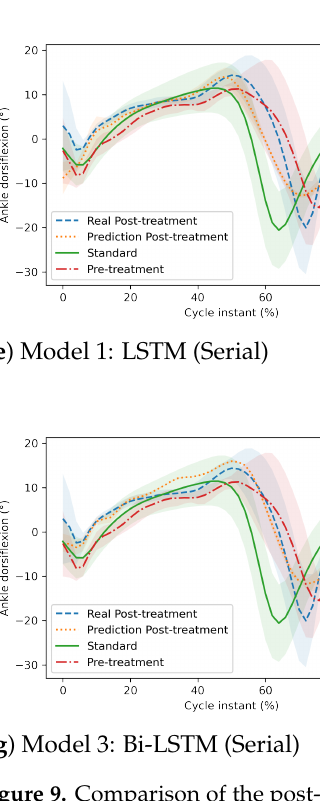
Figure 10. Cont. Figure 9. Comparison of the post-treatment gait trajectory of the knee and ankle joint in a patient diagnosed with MS. The first two models ( a , b ) are serial (Model 1 and Model 2), and the third and fourth models ( c , d ) are MTL models (Model 4 and Model 6), which represents the prediction of the knee joint. The fifth, sixth and seventh models ( e – g ) are serial (Model 1, Model 2, and Model 3), and the last model ( h ) is an MTL model (Model 4), which represents the prediction of the ankle